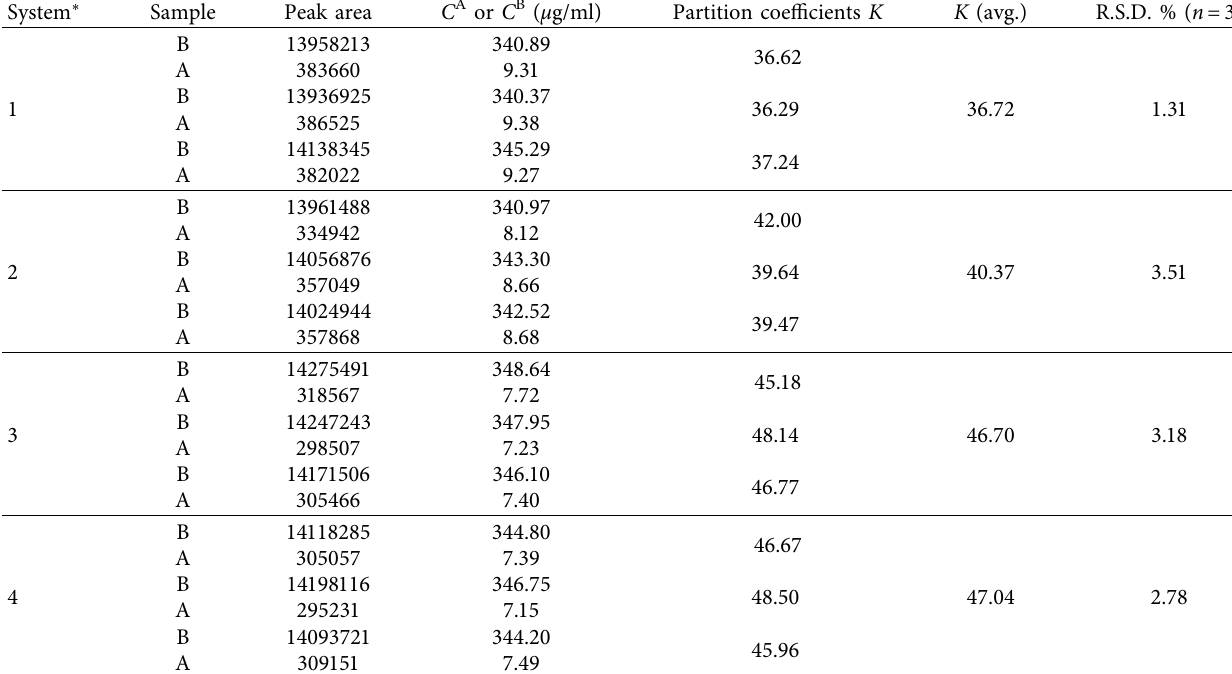
Table 1: The results of partition coefficients.